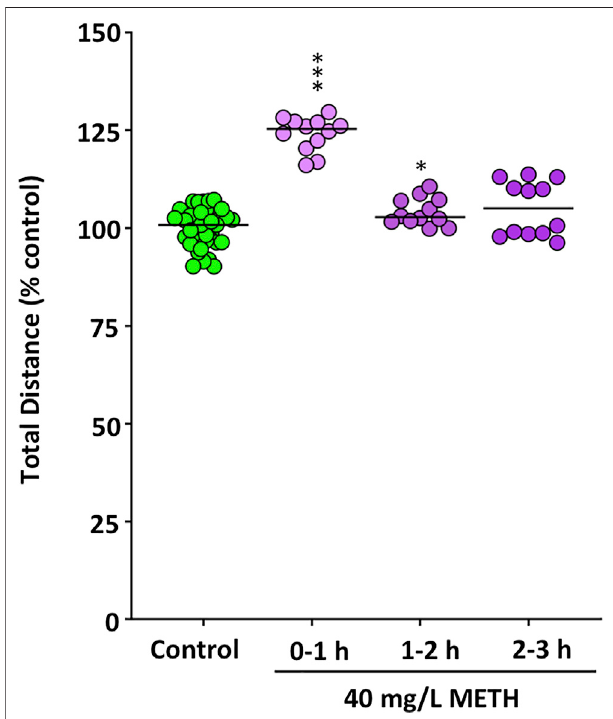
FIGURE 2 | Increased motor activity in fi sh waterborne exposed to 40 mg/L methamphetamine. The total distance (m) moved during the fi rst hour of the exposure for control fi sh and exposed fi sh was measured for each individual fi sh in shoals of six animals. Data reported as scatter plot with themedian( n (cid:2) 12),*** p < 0.001;Student ’ s t -test.Datafromtwoindependent